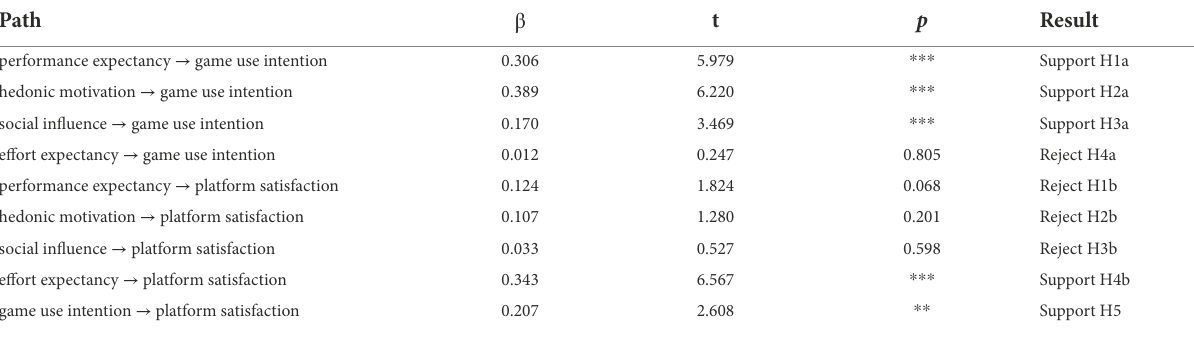
FIGURE 1 Empirical test results.